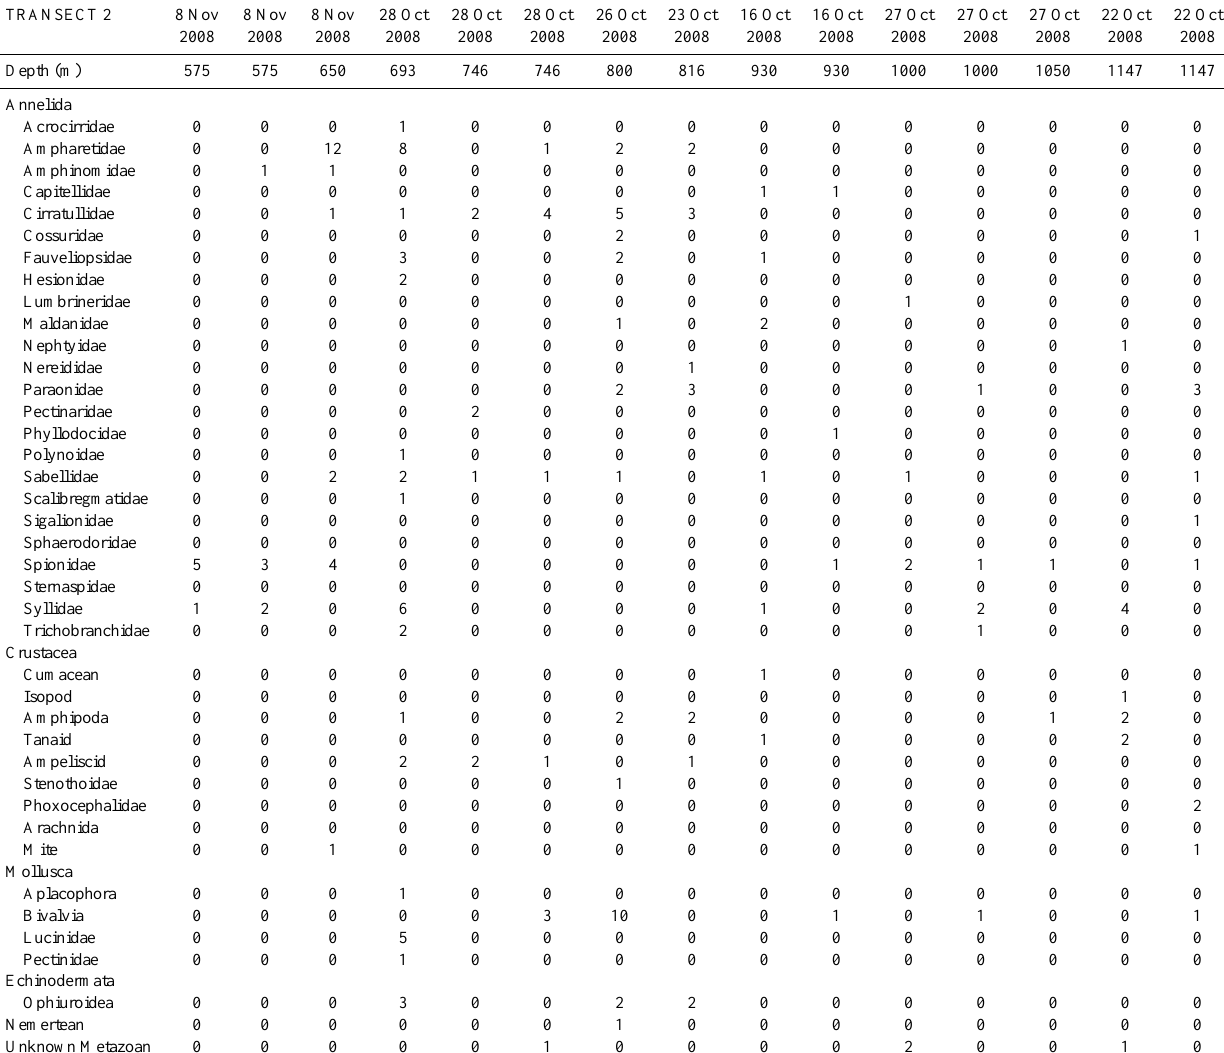
Table 3b. Background macrofaunal densities (no. per 8.3cm diameter core), transect 2 (see Table 1 for